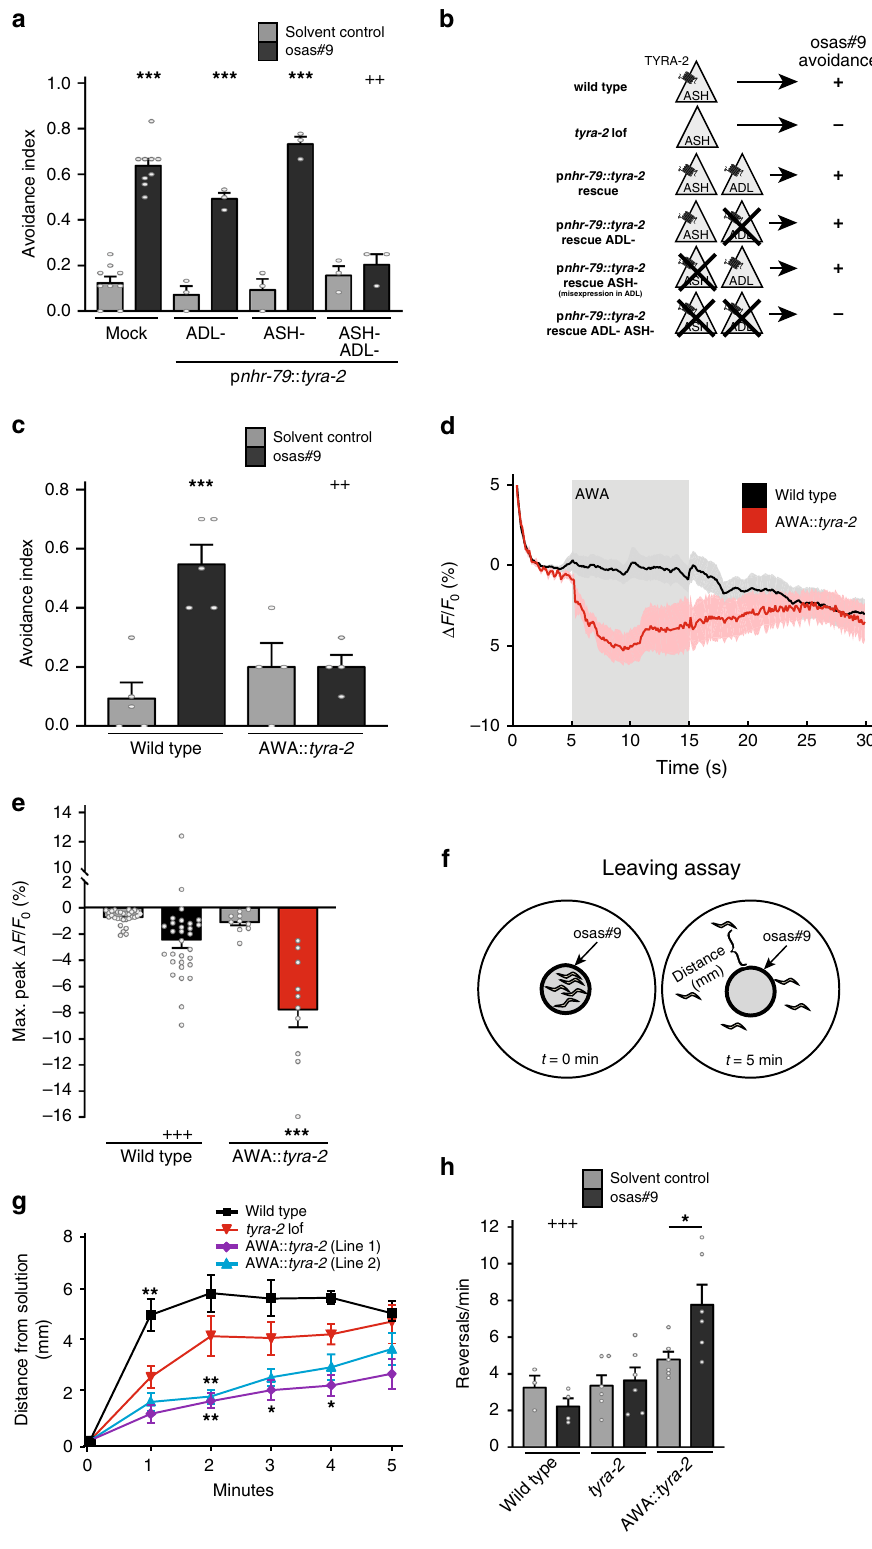
( tm1846 ) with co-injection marker p elt-2 ;mCherry by Knudra Transgenics. The promoter attB inserts were generated using PCR and genomic DNA or a plasmid. The tyra-2 insert was isolated from genomic DNA using attB5 ggcttatccgttgtggagaa and attB2 ttggcccttccttttctctt . PDONR221 p1-p5r and PDONR221 P5-P2 donor vectors were used with attB inserts. The resultant entry clones were used with the destination vector pLR305 and